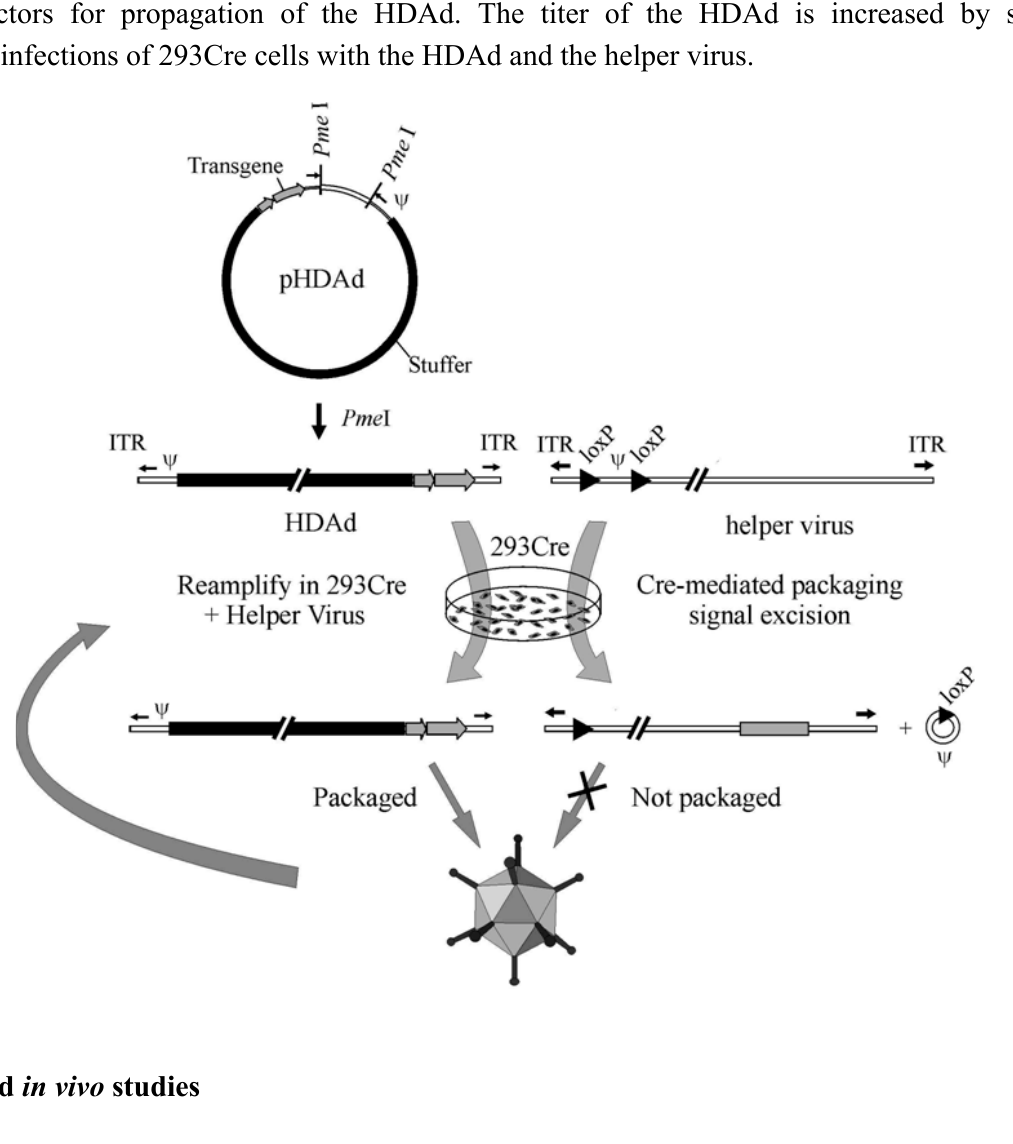
Figure 2 . The Cre/loxP system for generating HDAds. The HDAd contains only ~500 bp of cis -acting Ad sequences required for DNA replication (ITRs) and packaging ( ψ ); the remainder of the genome consists of the desired transgene and non-Ad stuffer